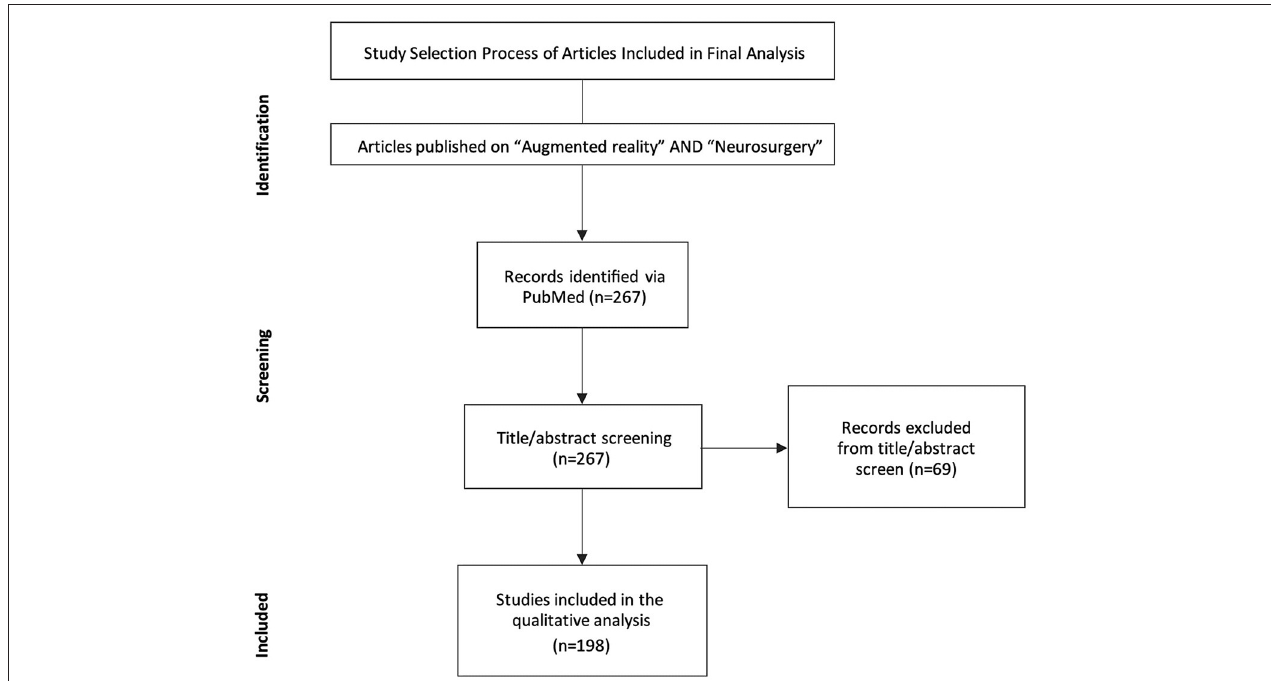
FIGURE 1 | Prisma flow diagram of the literature search.